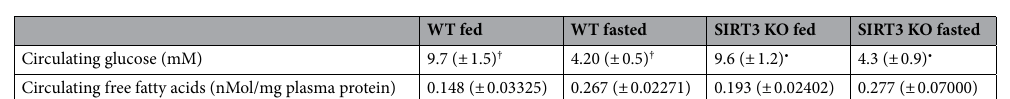
Figure 1. Fasting increases myocardial infarct size in WT, but not SIRT3 KO mice, with outcome dependent upon primary metabolic fuel. ( A ) Fasting increases infarct size in WT hearts, but not SIRT3 KO hearts in vivo. IS as a percentage of the area-at-risk (AAR). N = 6/group. Error bars indicate S.E.M. One-Way ANOVA *P ≤ 0.05. ( B ) Representative images of short-axis heart slices following dual staining with Evan’s blue and tetrazolium to stain the AAR and areas of infarction, respectively. ( C ) Fasting increases infarct size in ex vivo WT hearts perfused with 1.2 mM Palmitate, 5 mM Glucose. IS as a percentage of the area-at-risk (AAR). N = 6/ group. Error bars indicate S.E.M. One-Way ANOVA *P ≤ 0.05. ( D ) Representative images of short-axis heart slices following staining with tetrazolium to stain the areas of infarction. ( E ) Fasting decreases infarct size in ex vivo WT hearts perfused with 11 mM Glucose. IS as a percentage of the area-at-risk (AAR). N = 6/group. Error bars indicate S.E.M. One-Way ANOVA *P ≤ 0.05. ( F ) Representative images of short-axis heart slices following staining with tetrazolium to stain the areas of infarction.